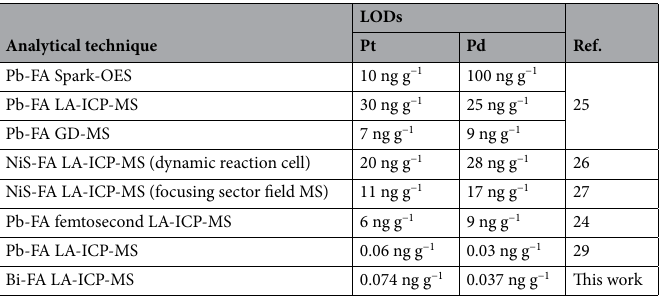
Table 8. Comparison of detection limits using this proposed technique and other conventional methods.